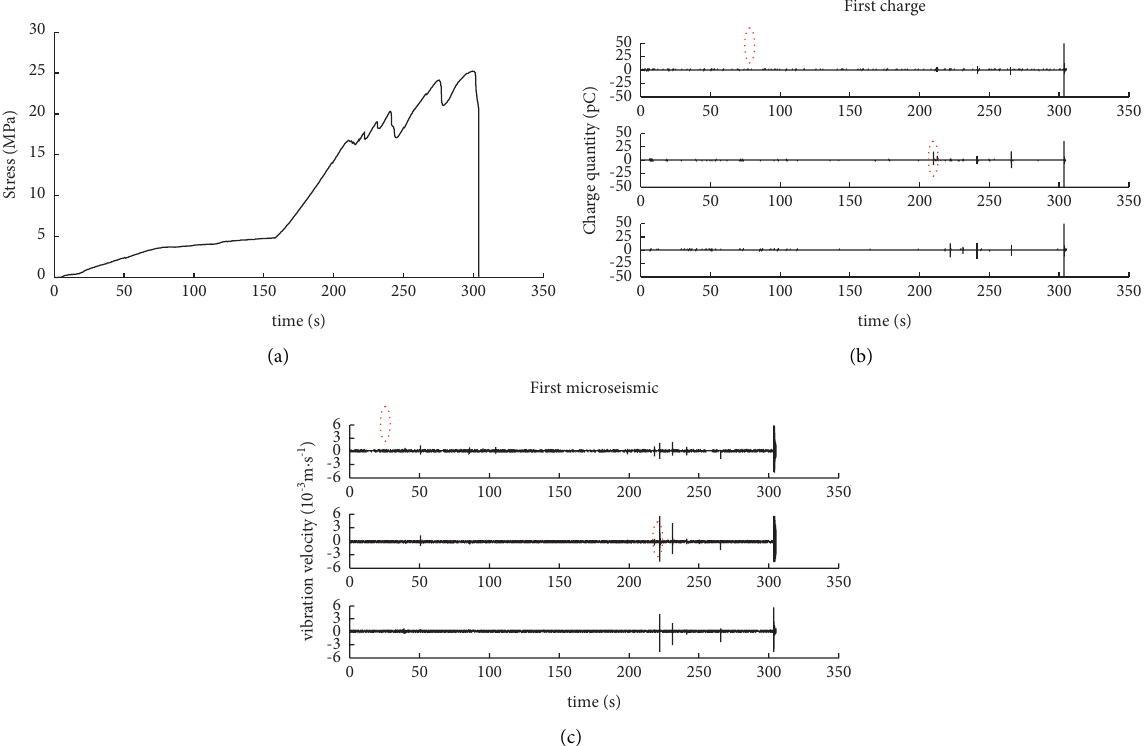
Figure 5: Charge induction and microseismic signals of sandstone when loading rate is 0.01 mm/s. (a) Stress curves. (b) Charge induction signals curves. (c) Microseismic signals